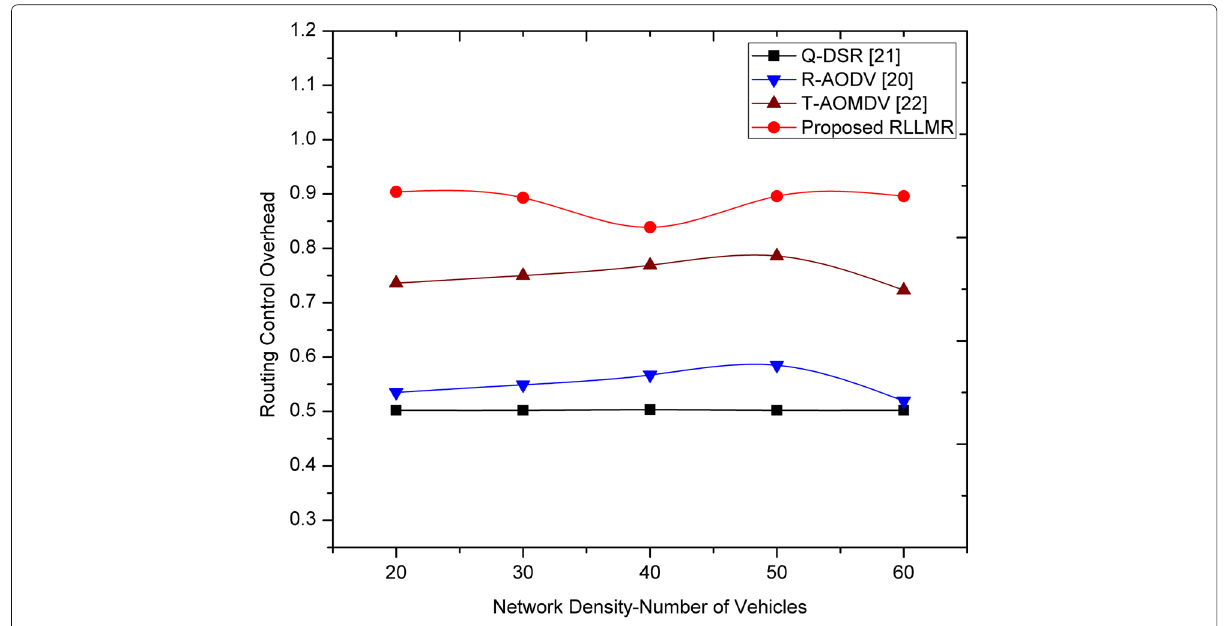
scheme to discover RLLMR scheme. The performance of RLLMR has been compared with T-AOMDV, R-AODV, and Q-DSR routing schemes using comprehensive simulations under different relative speeds and number of vehicles. The simulation results showed that RLLMR scheme has better average latency,